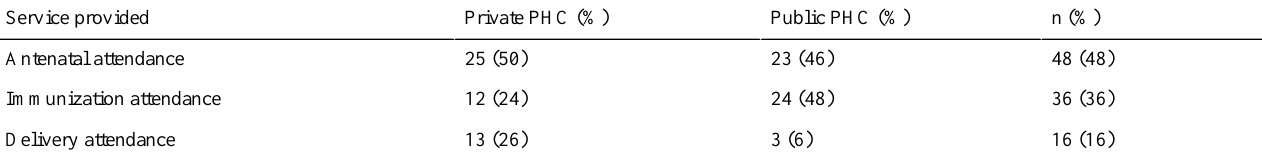
Table 5. Services provided by PHC a type.